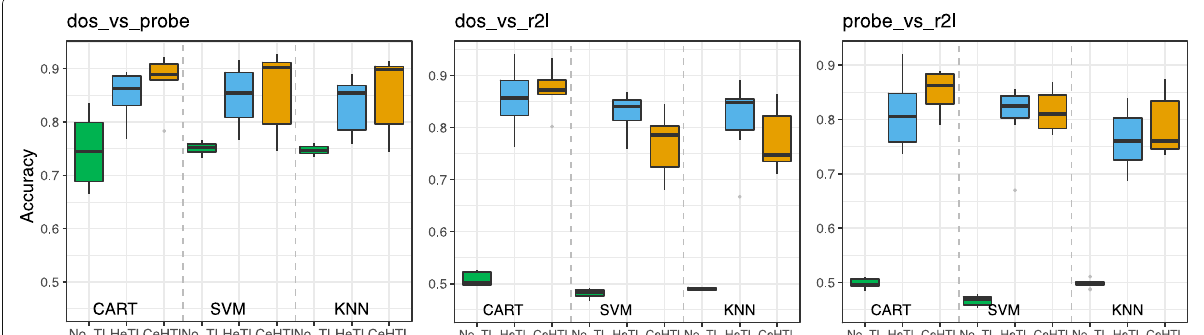
Fig. 2 Box plot of accuracy of transfer learning approaches and baselines on three main tasks